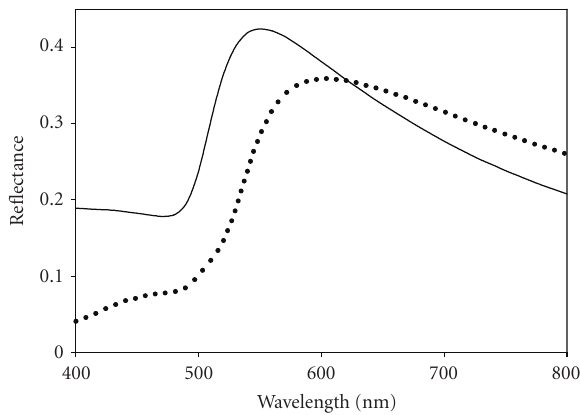
Figure 3: Reflectance of a two-dimensional array of 200nm gold nanoparticles deposited on glass separated by an inter-particle distance of 300nm. Solid line: dipolar approximation, dotted line: multipolar